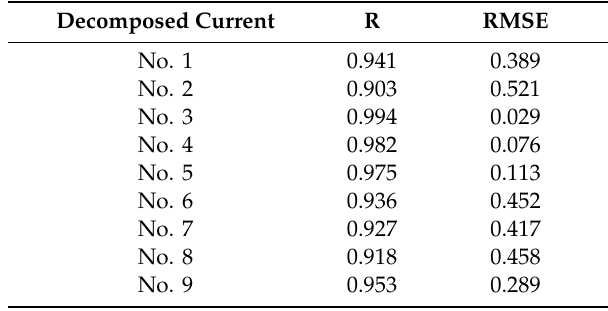
Table 1. Similarity coe ffi cient and root mean square error (RMSE) between the decomposed signal and the actual signal in first home.